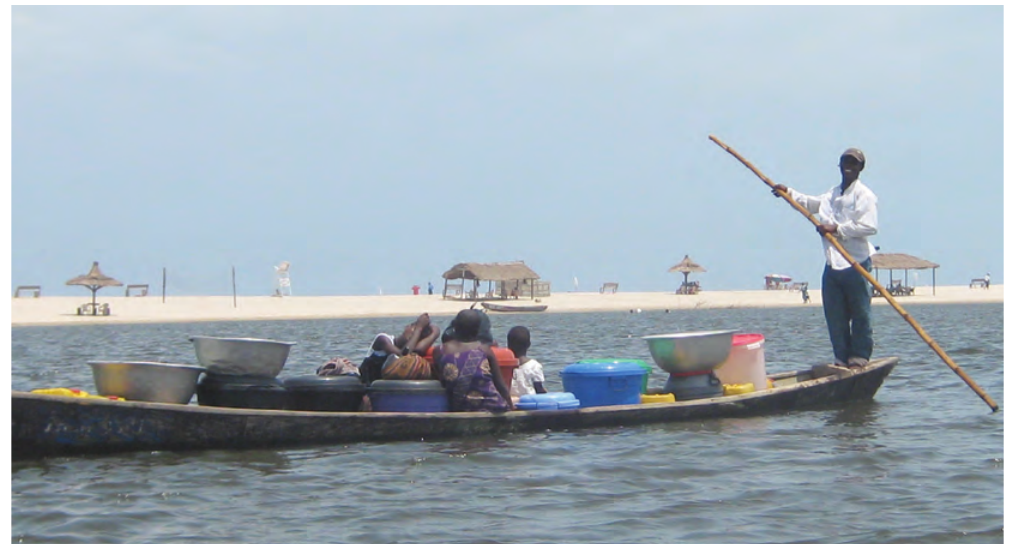
Figure 4. Women and children carting drinking water from Bortianor to Faana